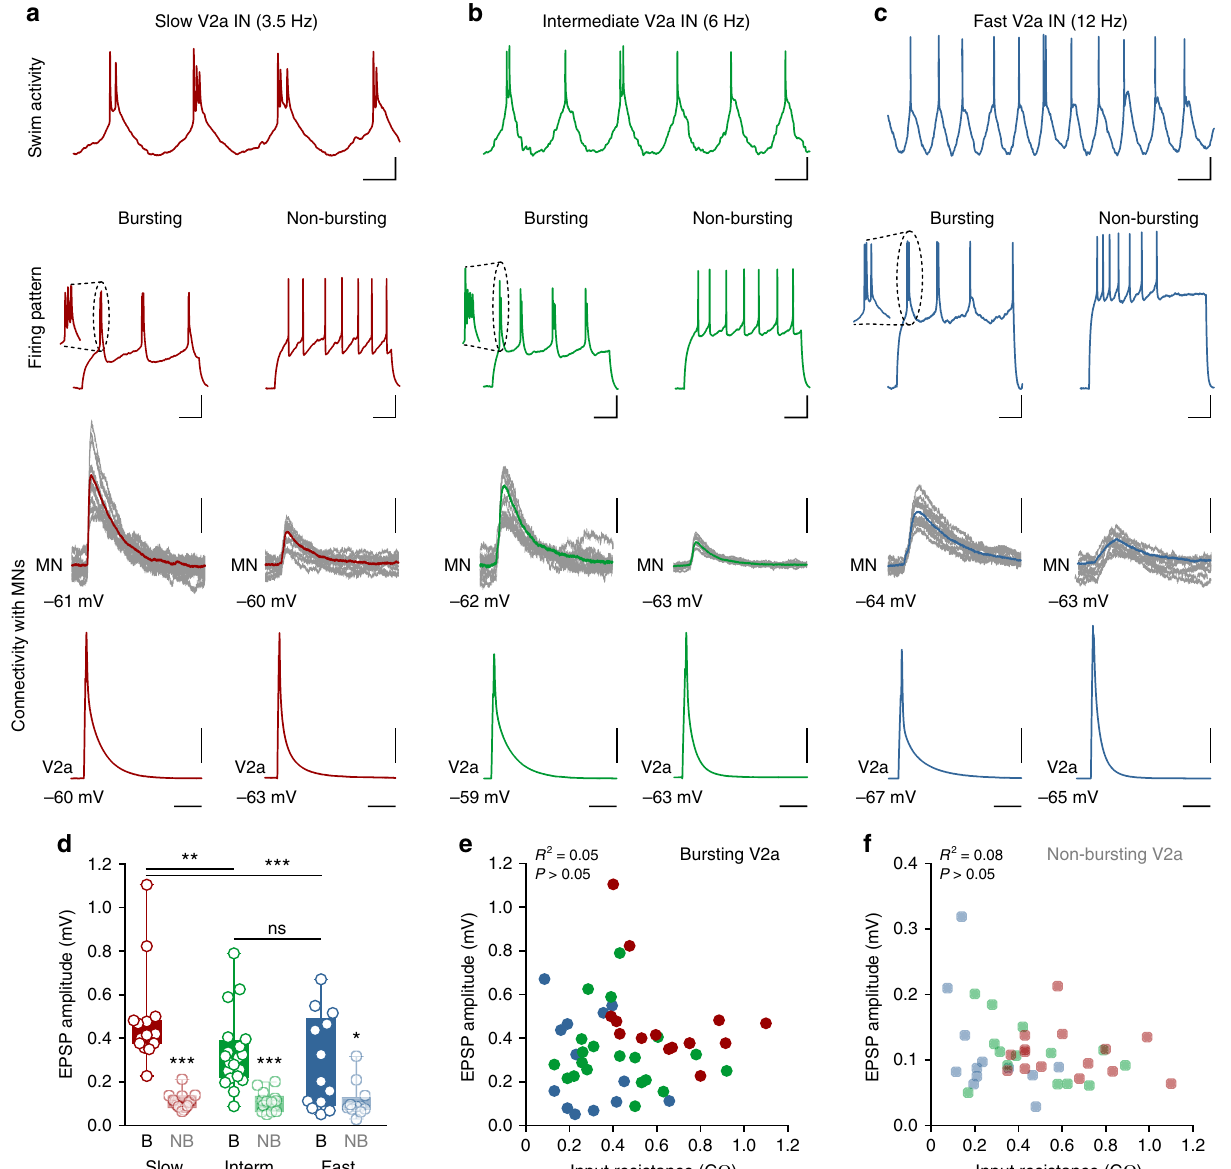
Fig. 2 Functional diversity of V2a interneurons and their synaptic drive to motoneurons. a Upper panel: swimming activity of a slow V2a interneuron. Middle panel: V2a interneurons of the slow circuit module displayed either bursting (left) or non-bursting (right) fi ring pattern in response to depolarizing current pulses. Lower panel: slow bursting-type V2a interneurons (left) always produced much larger EPSPs than non-bursting-type (right) in slow motoneurons. b Upper panel: swimming activity of an intermediate V2a interneuron. Middle panel: intermediate V2a interneurons consist of bursting- (left) and non-bursting types (right). Lower panel: intermediate bursting-type V2a interneurons (left) produced larger EPSPs than non-bursting-type (right) in intermediate motoneurons. c Upper panel: swimming activity of a fast V2a interneuron. Middle panel: V2a interneurons of the fast module also consist of bursting (left) and non-bursting types (right). Lower panel: fast bursting-type V2a interneurons (left) produced larger EPSPs than non-bursting-type (right) in fast motoneurons. d The amplitude of the monosynaptic EPSPs induced by V2a interneurons in the target motoneurons of the same module was always larger for the bursting-type (B) than non-bursting-type (NB) interneurons across modules (Interaction: F 2,90 = 5.63; P = 0.005; two-way repeated- measures ANOVA; bursting vs non-bursting: F 1,90 = 73.25; P < 0.0001; two-way repeated-measures ANOVA; n = 15 pairs of the slow module; n = 20 pairs of the intermediate module; and n = 13 of the fast module; the boxes are bound by the 25th and 75th percentiles, whiskers extend from min. to max.). e , f There was no correlation between the motoneuron input resistance and the EPSP amplitude induced by bursting-type ( e ) and non-bursting-type ( f ) V2a interneurons ( P > 0.05; Pearson ’ s correlation). Scale bars, 100 ms, 10 mV (swim and fi ring pattern); 20 ms, 10 mV, 0.2 mV